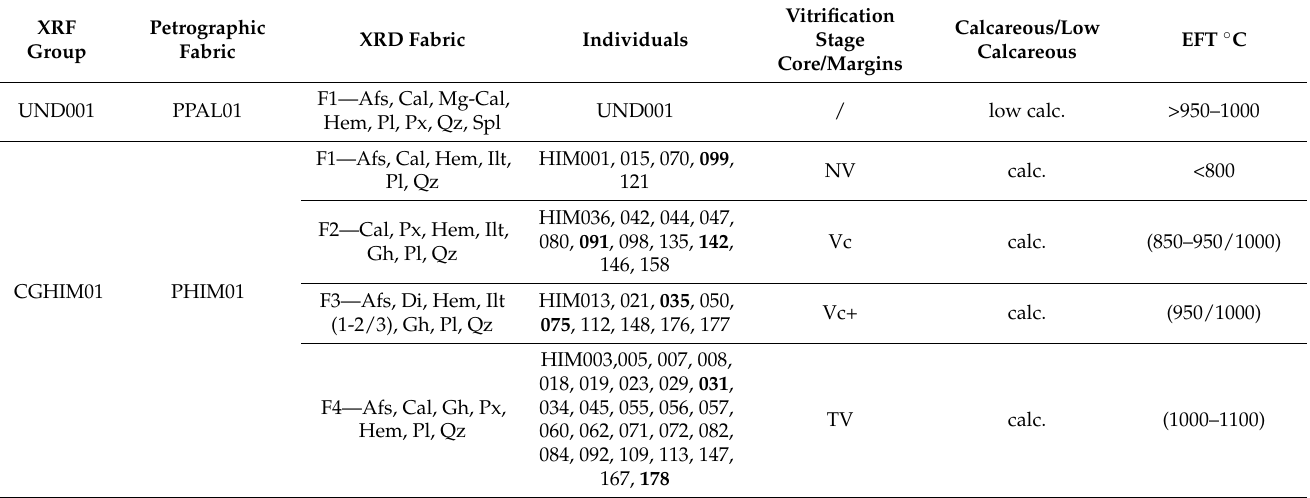
Table 4. Table of the estimated equivalent firing temperature (EFT) according to X-ray diffraction (XRD) fabrics and vitrification stages by scanning electron microscopy (SEM, in bold individuals, examined). Afs: alkali feldspar; Cal: calcite; Px: pyroxene; Gh: gehlenite; Hem: hematite; Ilt: